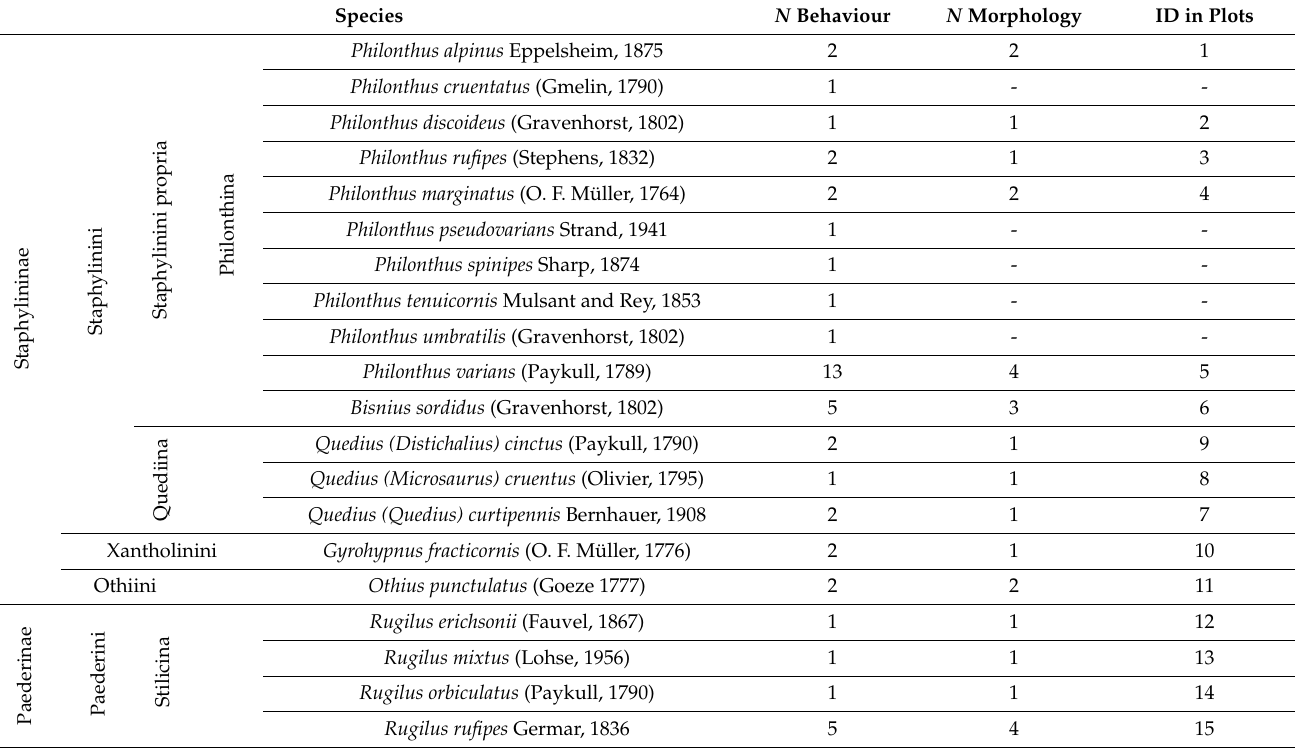
Table 1. List of species considered in this study. N : number of individuals considered in be- havioural and morphological examinations. ID numbers correspond to species data points in figures where applicable. Species N Behaviour N Morphology ID in